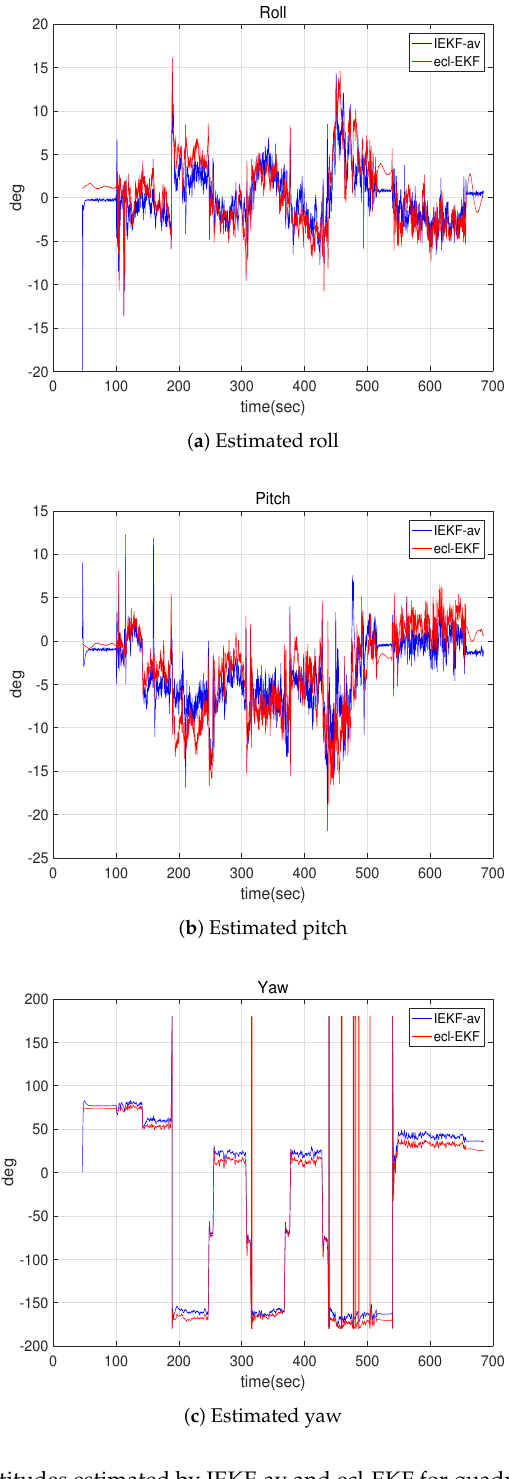
Figure 11. Attitudes estimated by IEKF-av and ecl-EKF for quadrotor flight